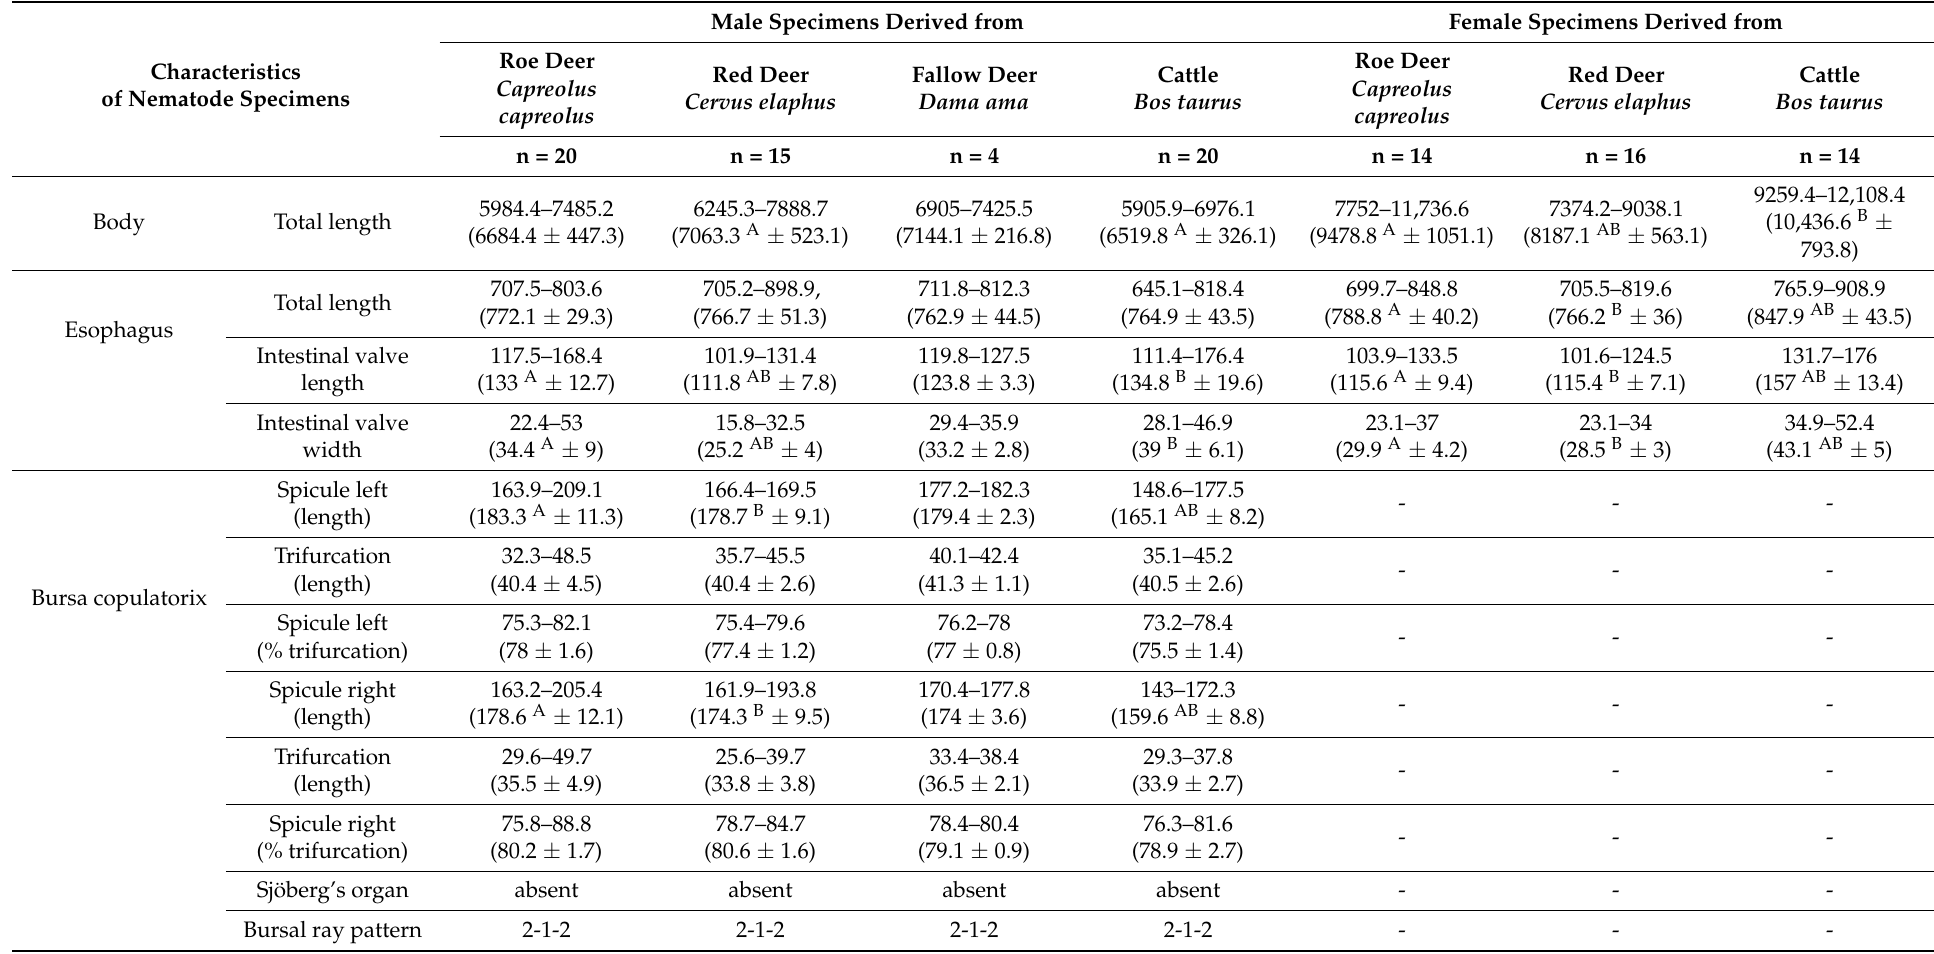
Table 2. Measurements of Ostertagia leptospicularis derived from different host species (presented in micrometers unless indicated otherwise and given as a range followed by the mean ± SD in parentheses; values in rows with the same letters differ